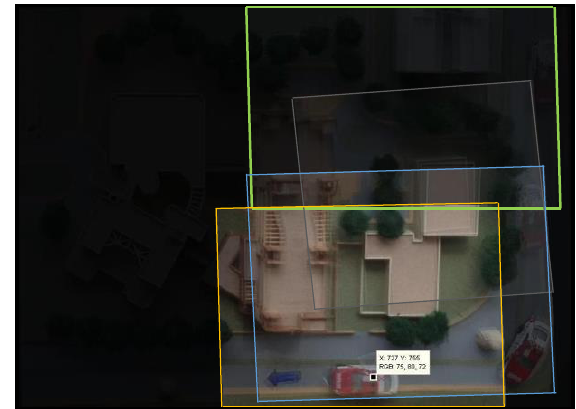
Figure 13. Geolocation of target in the fourth image frame. The image shows the four overlapping frames and the target is tracked in the fourth frame in near real time